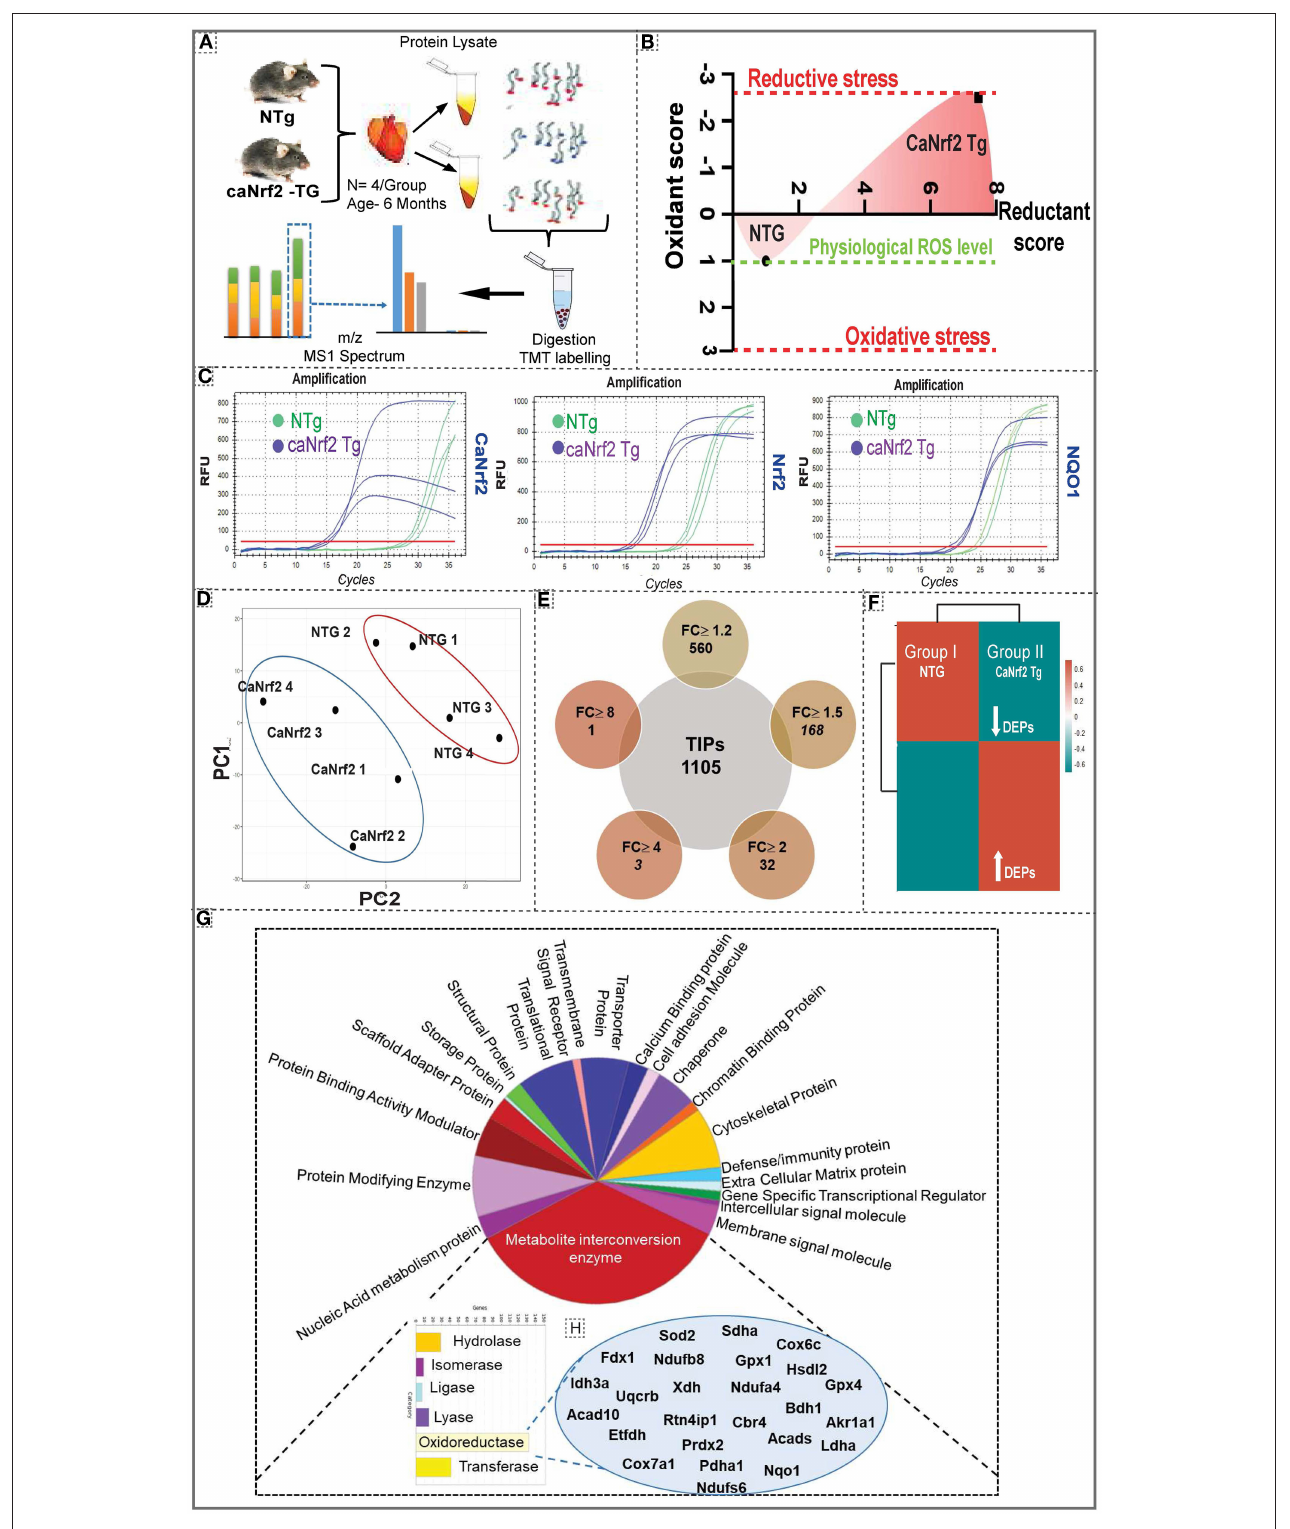
FIGURE 1 | Effect of chronic reductive stress on myocardial proteome. (A) Overall methodology adopted for Tandem Mass Tagged LC-MS/MS analysis. Heart tissues were harvested from non-transgenic (NTg) and caNrf2-Tg ( N = 4 mice/group) and protein concentration was determined in homogenates with BCA kit (Bio-Rad, USA). After trypsin digestion, peptides were reconstituted in 0.5M TEAB and processed for TMT tagging (Tandem Mass Tag kit, ThermoFisher Scientific). LC-MS/MS